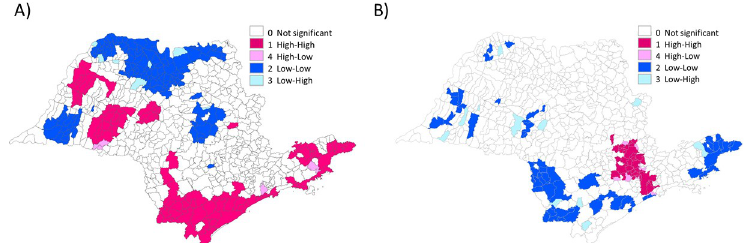
Fig 4. Lisa cluster map of neonatal asphyxia-associated mortality and mean per capita GDP rates from 2004 to 2013, in S ã o Paulo State (BR). A) Neonatal asphyxia-associated mortality after smoothing with local Bayes estimates. B) Mean per capita GPD. Maps (A) and (B) represents municipalities with significant G box-plotted according to their dispersion diagram, i.e. areas (1) and (2) with positive spatial correlation, and areas (3) and (4) with negative spatial correlation. Data are presented for each 645 S ã o Paulo Municipalities (Brazil), from 2004 to 2013.